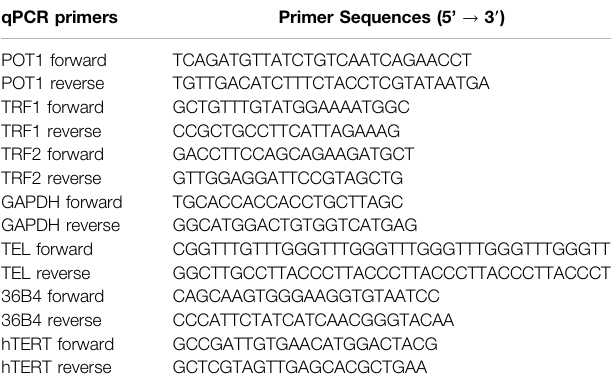
TABLE 2 | List of primers used in this